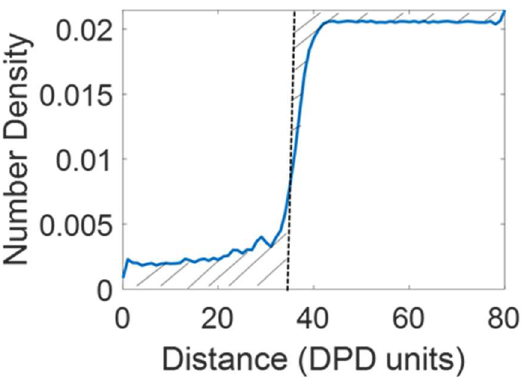
Figure 3. The construction of the Gibbs dividing surface (GDS), dotted black line, for a water number density profile. The shaded areas to the left and to the right of the GDS are equal. Similar procedure was used to calculate the GDS for polyelectrolyte membranes (PEM).